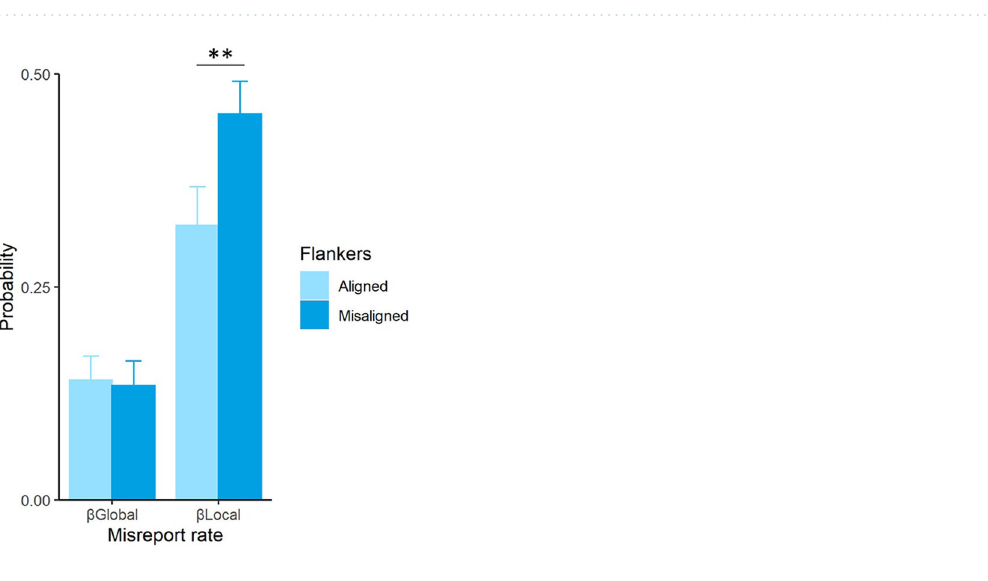
Figure 3. Model parameters from the fitting of the Global–Local model. ( A ) Guessing rate (γ), ( B ) Mean variability (σ, in degrees), and ( C ) target reporting rate (P T ) for each display condition. U uncrowded, FA flankers aligned, FM flankers misaligned. Error bars represent standard error.